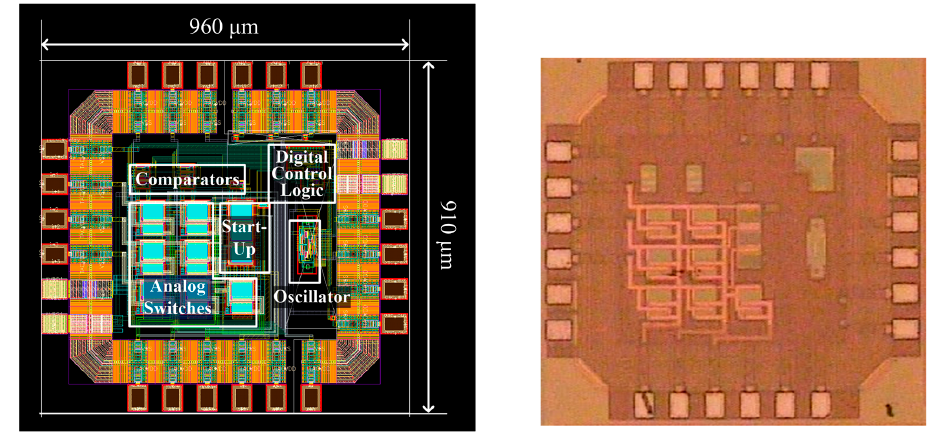
Figure 9. Layout and die micrograph of the energy management IC.